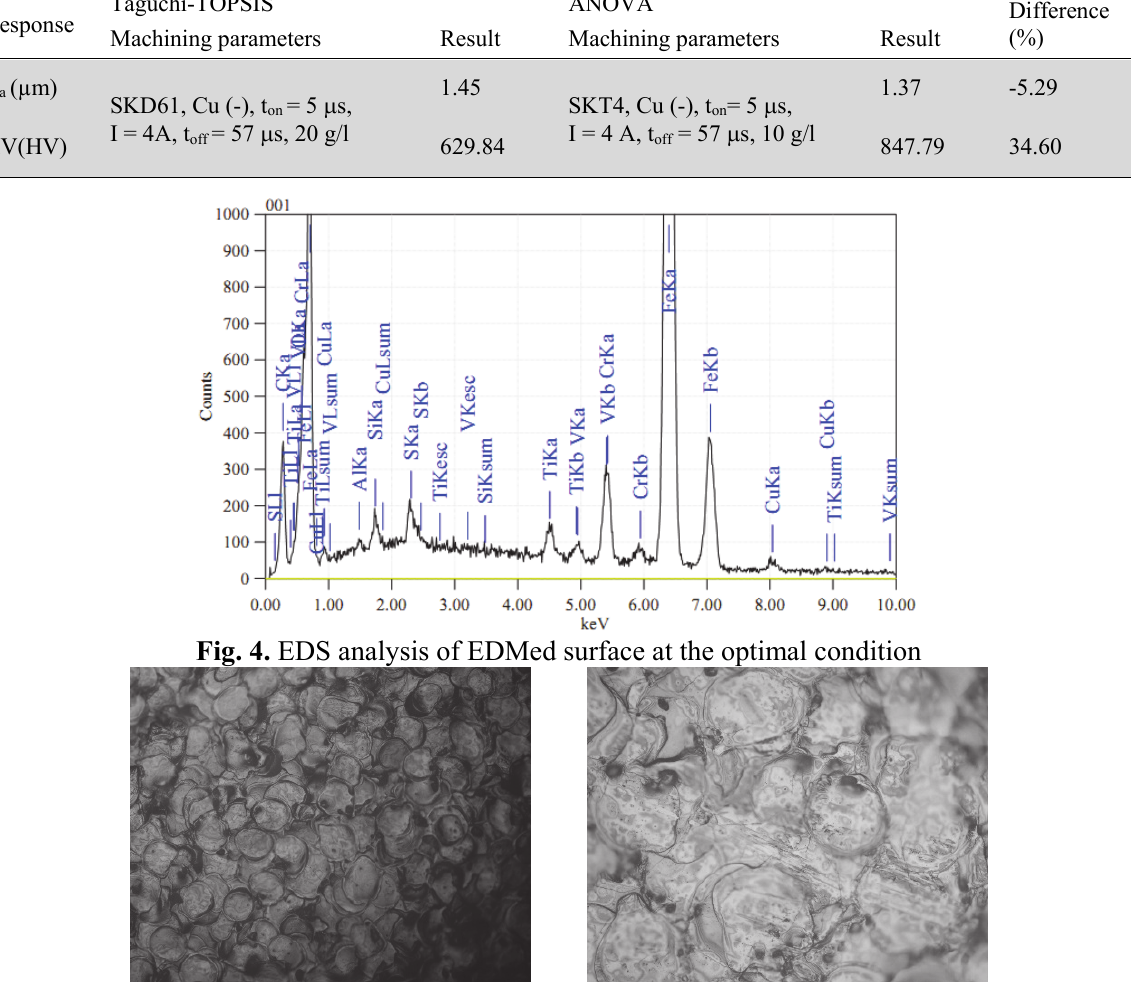
Fig. 4. EDS analysis of EDMed surface at the optimal condition